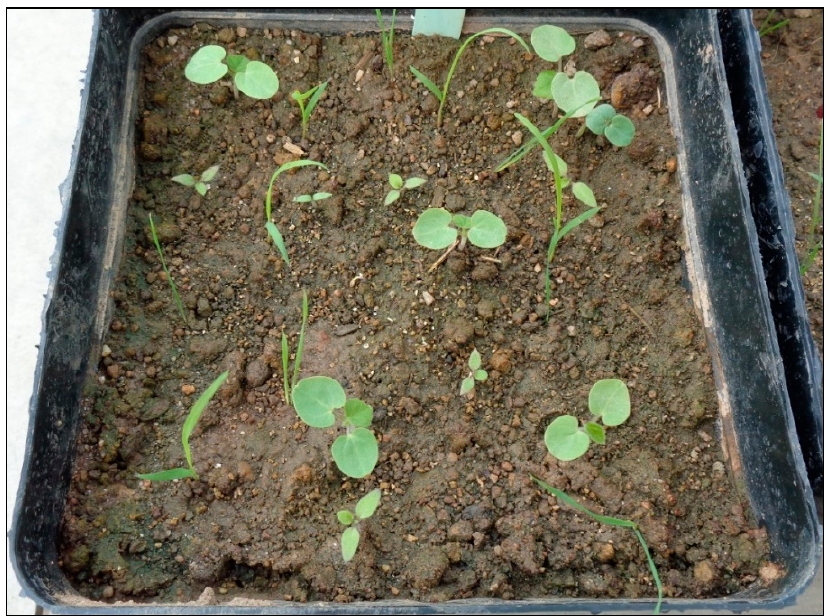
Figure 2. Seedlings of Alopecurus myosuroides , Echinochloa crus-galli , Abutilon theophrasti, and Solanum nigrum transplanted into the pots 2 days after sowing maize to induce early weed competition.